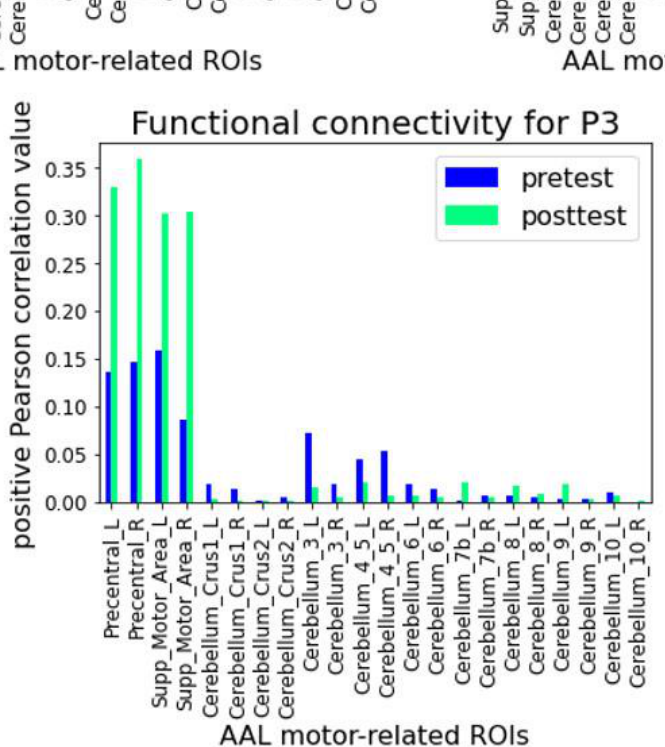
Figure 3. Mean positive correlation of motor-related areas and seed for each participant before (blue) and after (green) training with NeuroR. The AAL areas along the x-axis are listed in Table 2.